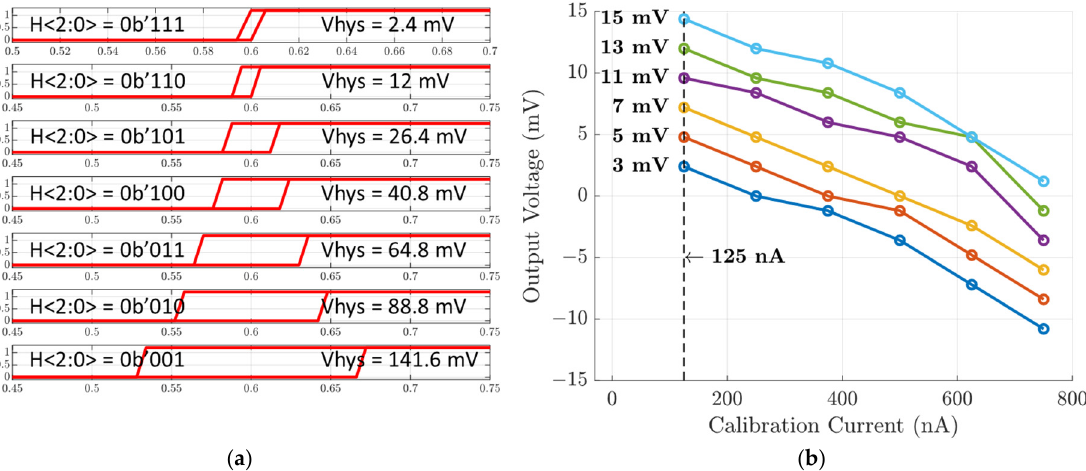
Figure 8. ( a ) Simulated programmable hysteresis window through a digital code; ( b ) simulated output voltage ( V o 2 ) of the comparator according to the variation of calibration current ( IB 2 ).